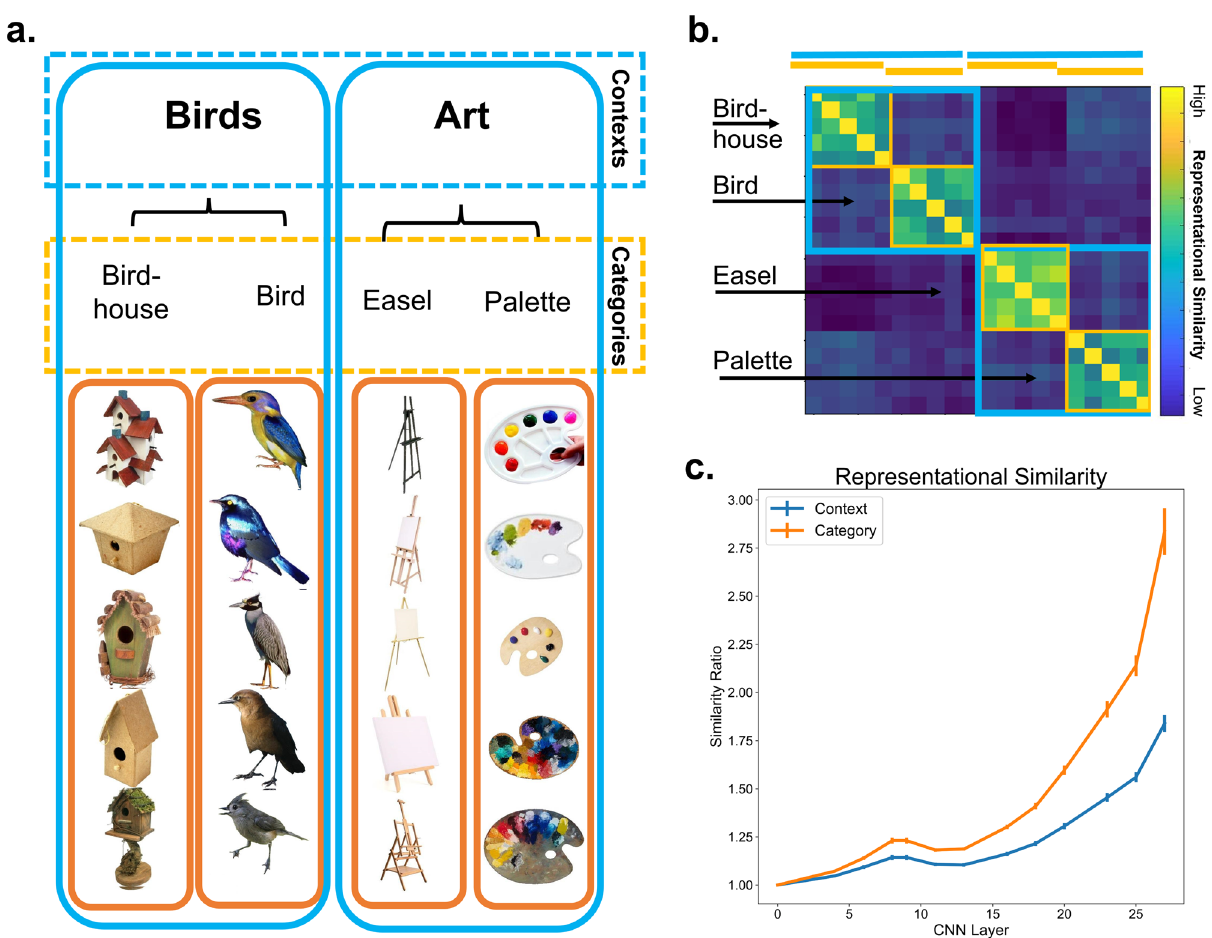
Figure 2. (a) Examples of the contrasts of interest. Five different exemplars of each object were used. Category similarity was assessed by comparing representations in the CNN across exemplars of the same category (orange outlines). Context similarity was assessed by comparing the representations of exemplars across the object paired categories (e.g., one easel and one palette exemplar, blue outlines). ( b) Example of an ideal similarity matrix for each comparison using simulated data. ( c) Representational similarity of images in the same category (orange) and same context (blue) at each layer of VGG16 CNN. Similarity computed as ratio of average in-group versus out-group similarities for each group. Error bars represent standard error of the